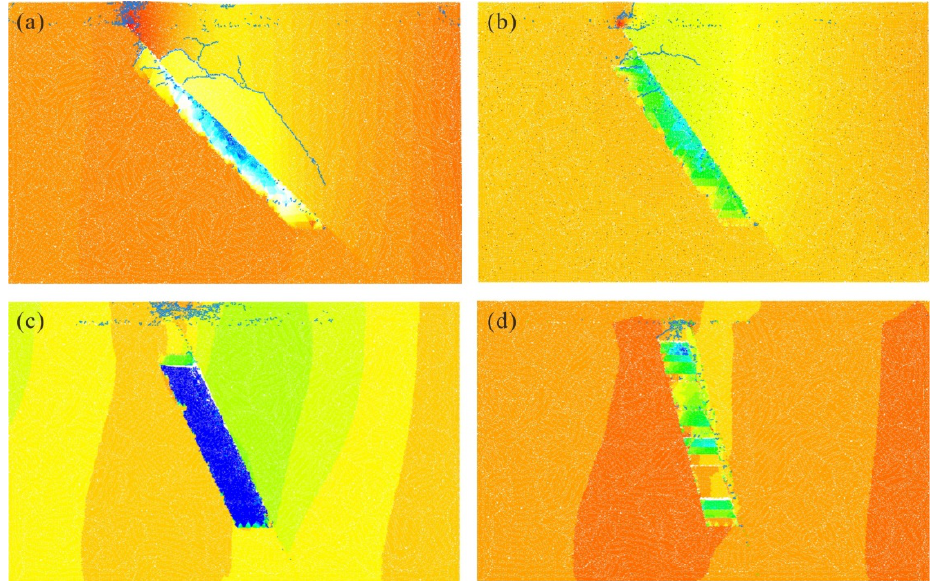
Figure 8. Failure modes for the mining of an ore body with different dip angles. ( a ) Dip angle of 45°; ( b ) dip angle of 55°; ( c ) dip angle of 65°; ( d ) dip angle of 75°.